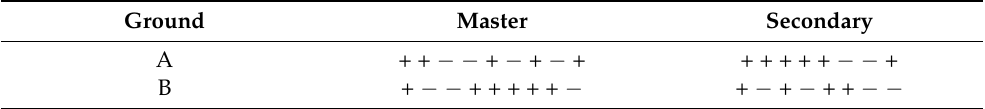
Table 1. Phase codes of eLoran signals.